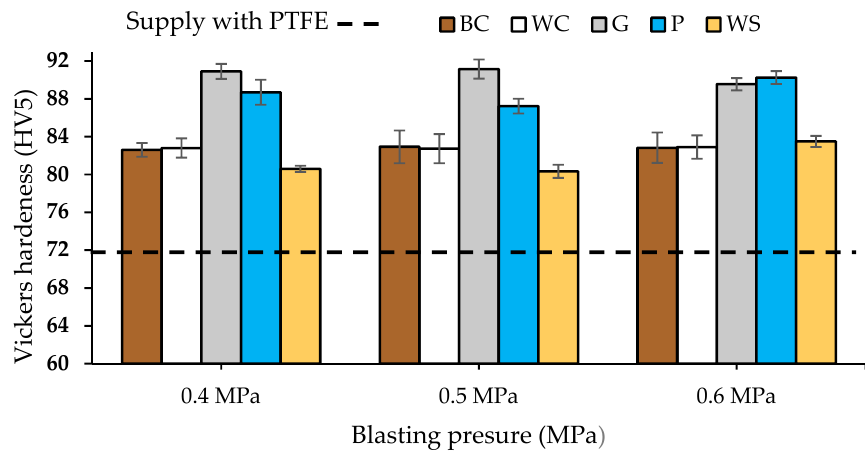
Figure 5. Vickers hardness values with loads of 5 kg (HV5) after stripping PTFE coatings on an EN AW 5182 substrate with di ff erent abrasives at 0.4, 0.5, and 0.6 MPa: (i) BC-brown corundum, (ii) WC-white corundum, (iii) G-glass microspheres, (iv) P-plastic particles, and (v) WS-walnut Shell.